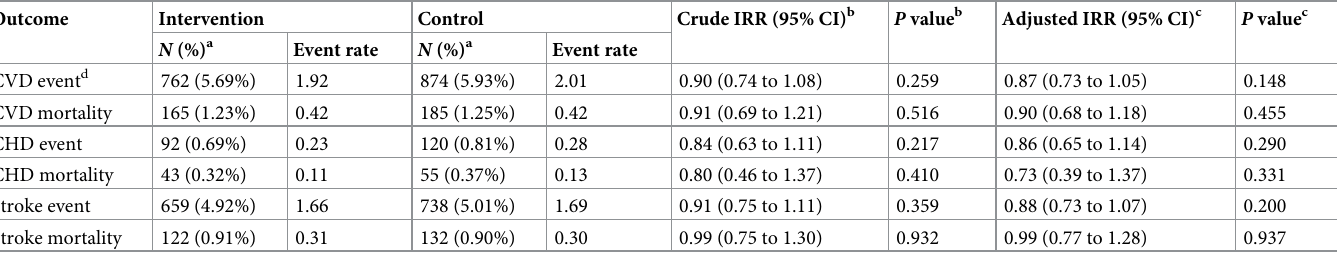
Table 3. Comparison of primary and secondary outcomes for disease event rates between the intervention and control arms (individual-level data analyses). Outcome Intervention Control